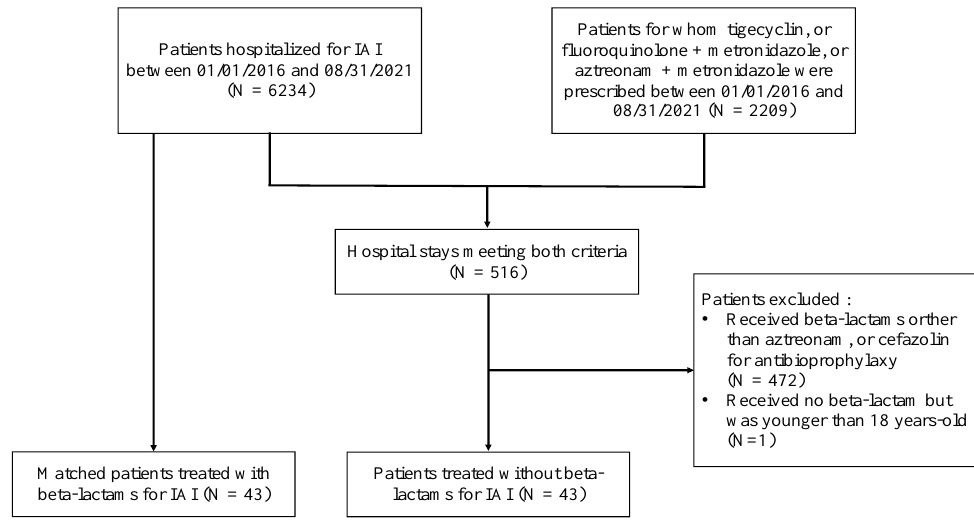
Figure 1. Flow chart of the study population.